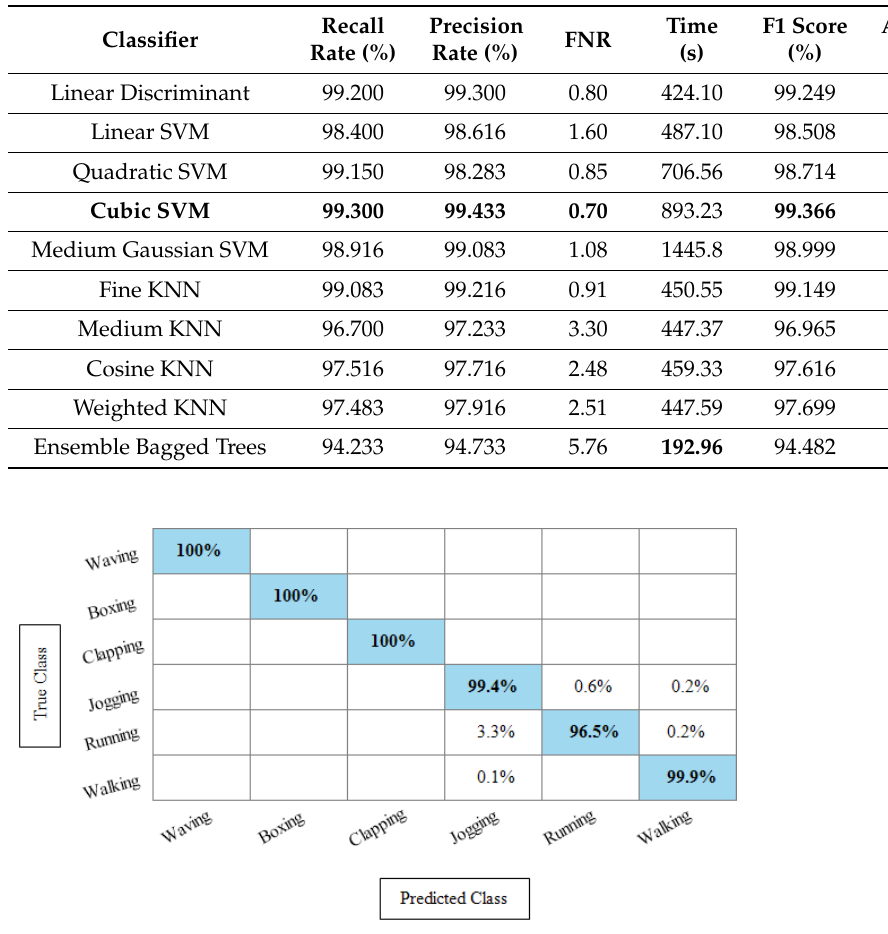
Figure 8. TPR-based confusion matrix of KTH dataset after fusion of deep features using SbE approach. Table 4. Achieved results on Hollywood dataset after fusion of deep features using SbE approach. The bold represents the best obtained values.